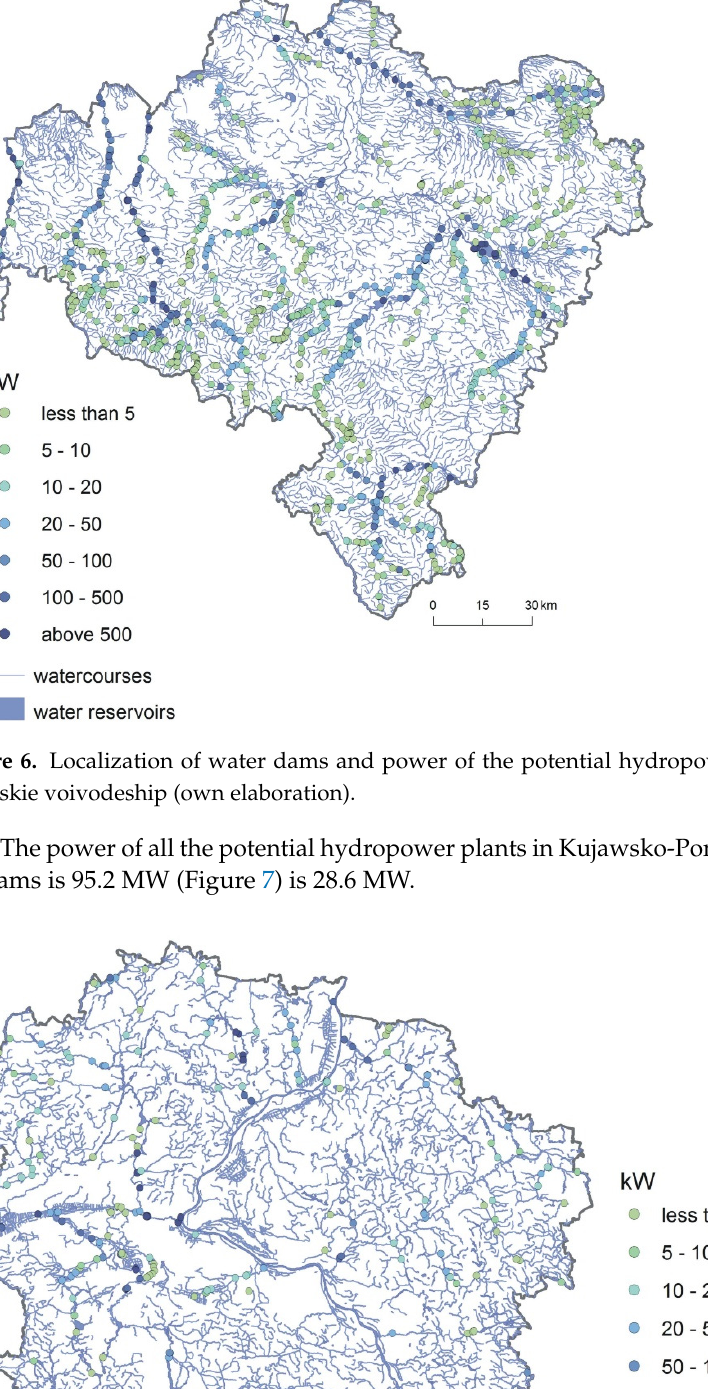
Figure 8. Localization of water dams and power of the potential hydropower plants in the Lubelskie voivodeship (own elaboration).